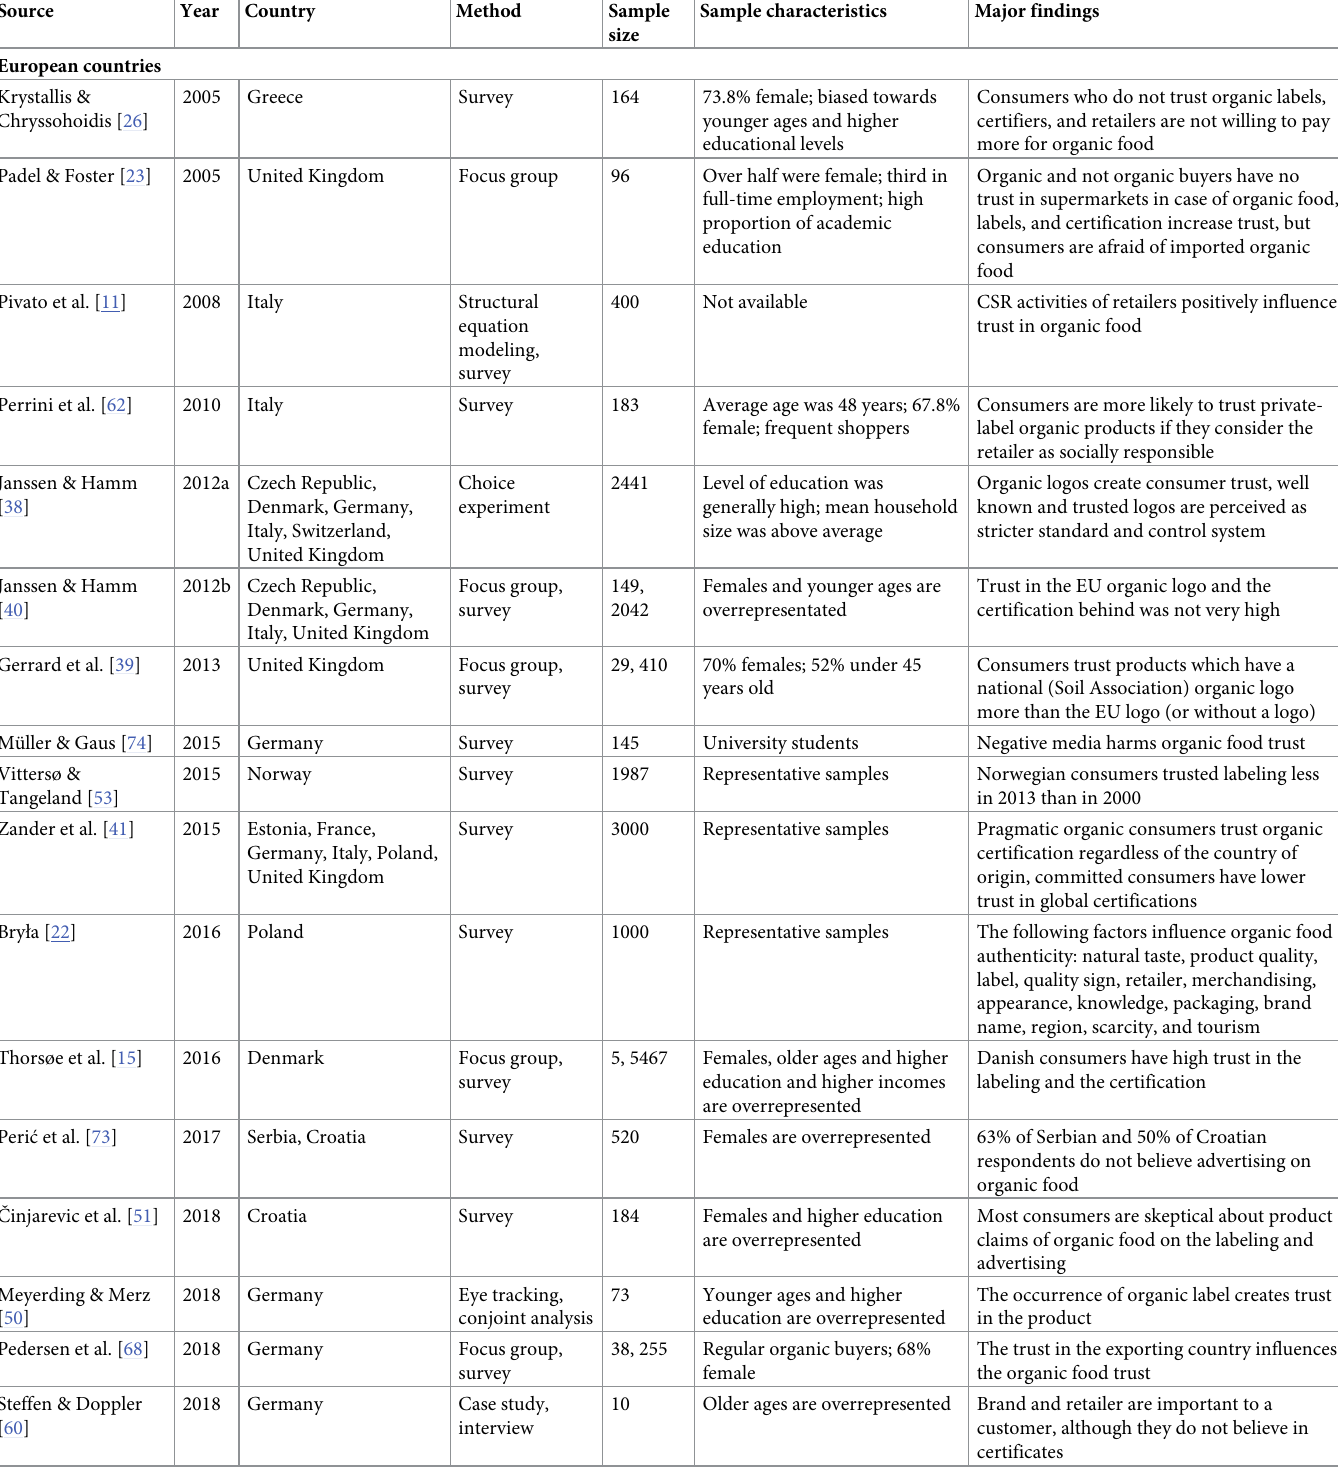
Table 1. Selected articles and major